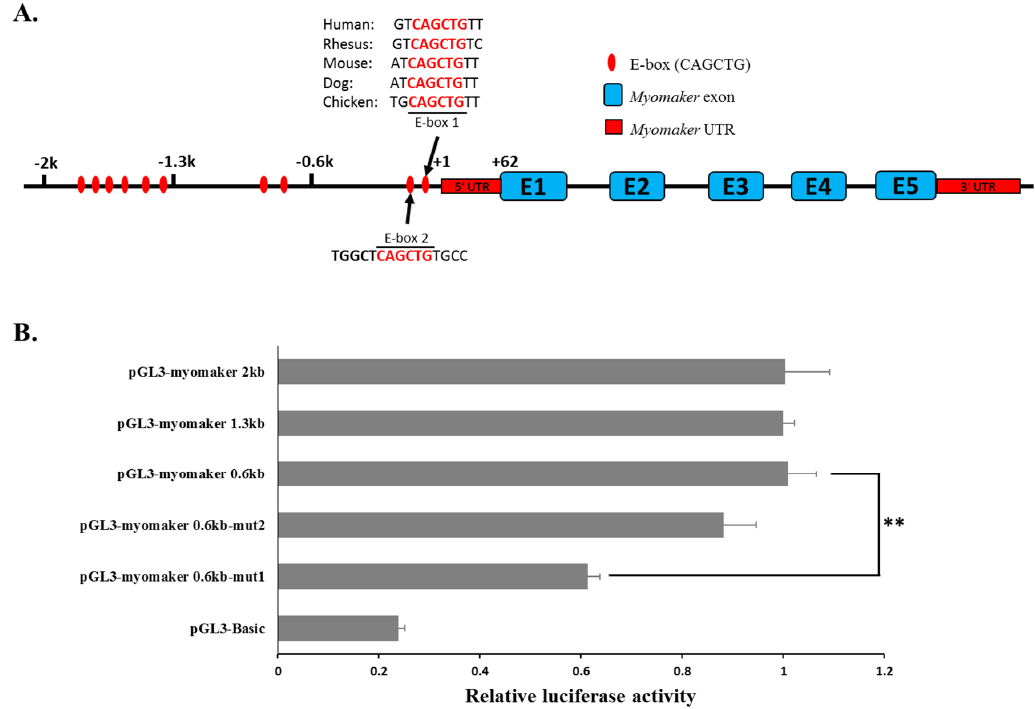
Figure 4. Myomaker transcription is controlled by a conserved promoter E-box element in chicken. ( A ) The location of the ten E-boxes in the 2-kb upstream region of the Myomaker TSS; ( B ) Identification of the core region in the Myomaker promoter by luciferase reporter assays. The 0.6-kb, 1.3-kb and 2.0-kb upstream regions of the Myomaker TSS were inserted into the pGL3 plasmid and then transfected into the established myotubes. Luciferase activities were measured after 36 h transfection. The data in B are mean ± S.E.M. with four cultures per group. One-way ANOVA with a Bonferroni post-hoc tests was used to analyze the data. ** p < 0.01.